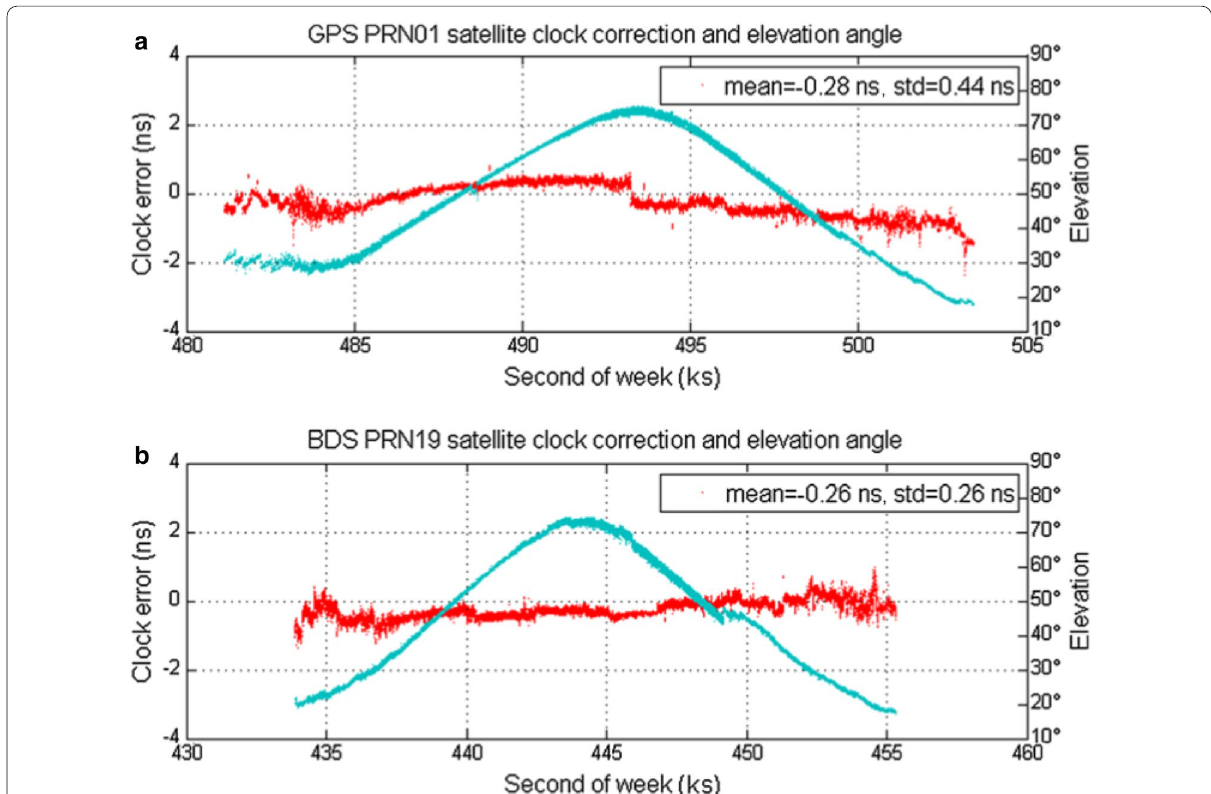
Fig. 2 Long-term clock corrections of GPS PRN01 and BDS